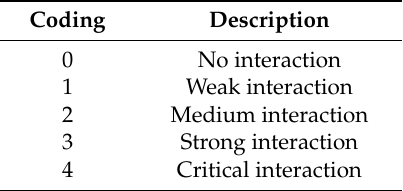
Table 2. ESQ interaction matrix coding [28].